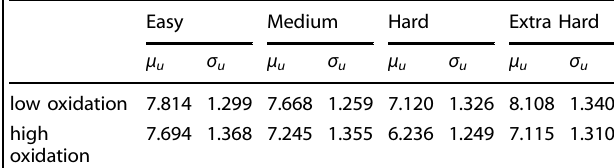
Table 4. Summary of statistics of random GOs in all experiments (unit: